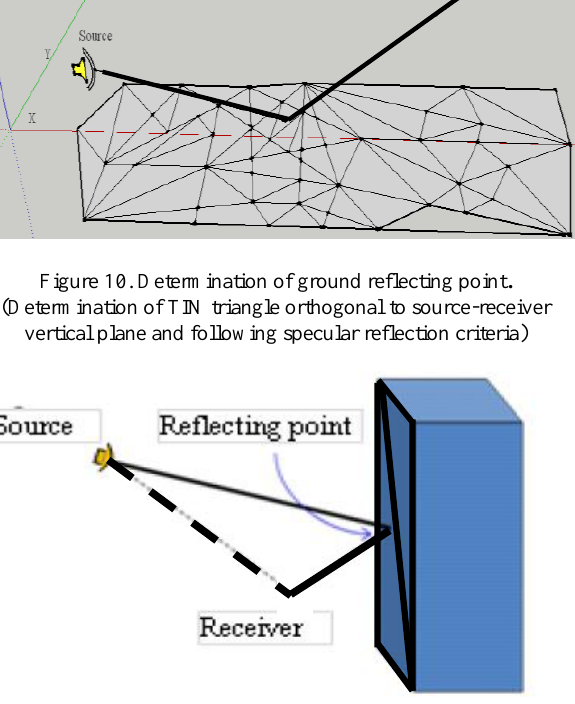
Figure 11. Determination of reflection from